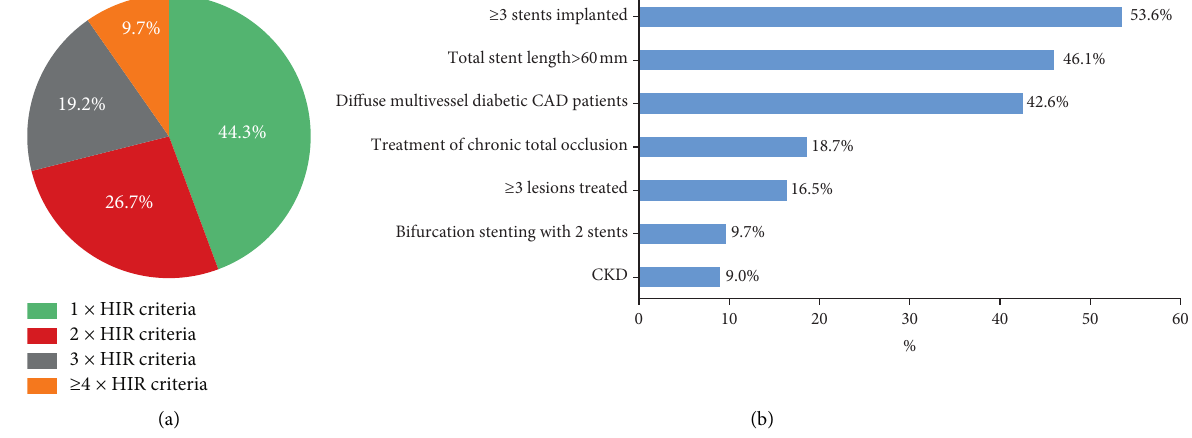
Figure 2: The distribution and prevalence of the ESC stent-driven high ischemic risk criteria components among patients fulfilling high ischemic risk definition. (a) The sum of high ischemic risk criteria satisfied by each patient was used to stratify patients according to the number of times they fulfilled the 2017 ESC DAPTguideline stent-driven high ischemic risk definition. The pie chart shows the distribution of HIR patients with increasing numbers of multiple coexisting criteria (1 × HIR to ≥ 4 × HIR). (b) Bars indicate the overall prevalence of each high ischemic risk criterion among patients qualified as being at high ischemic risk. HIR � high ischemic risk. Other abbreviations are as in Figure